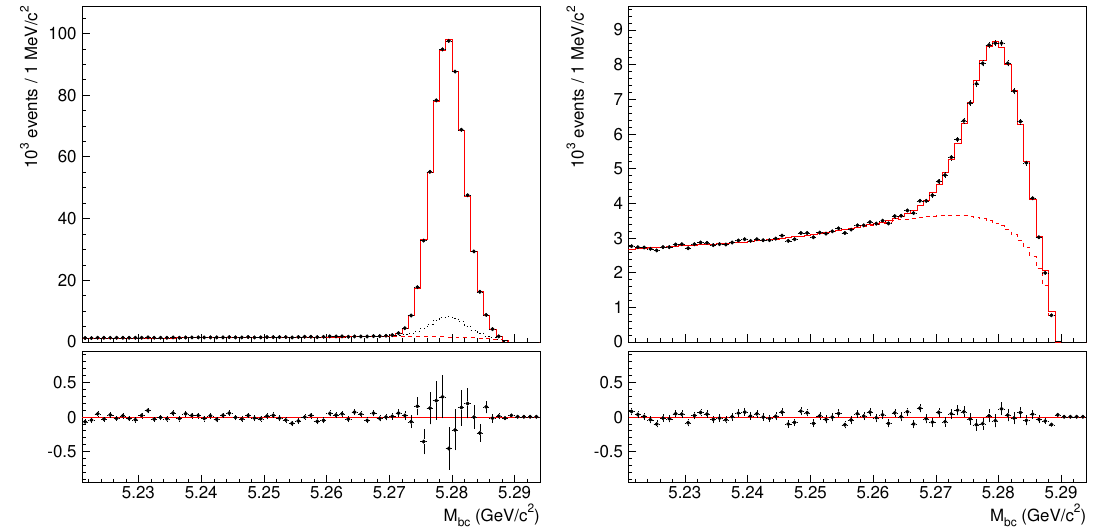
Figure 4 . The M bc distributions in the ∆ E 0 signal region (left) and sidebands (right). Points with error bars are data, solid red histogram is the result of the simultaneous fit to these distributions and the cross section energy dependence (figure 5), dashed red histogram is the smooth background, dotted black histogram is the peaking background in the ∆ E 0 signal region. The lower panels show the